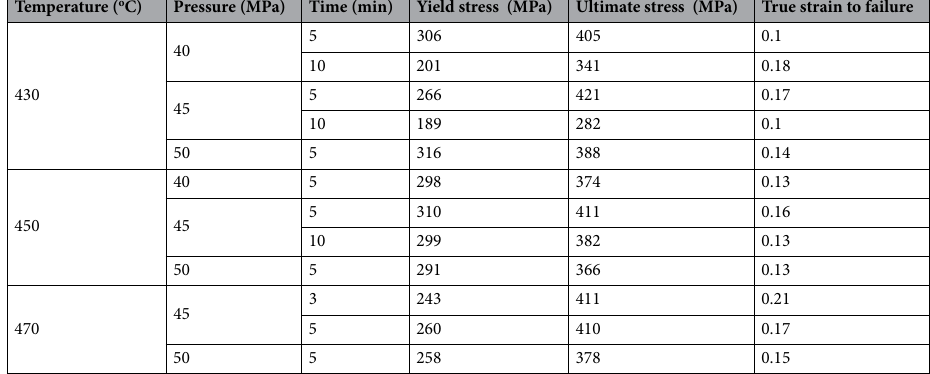
Table 2. The values of the compressive mechanical properties of the sintered Mg–15Gd–1Zn bulks.